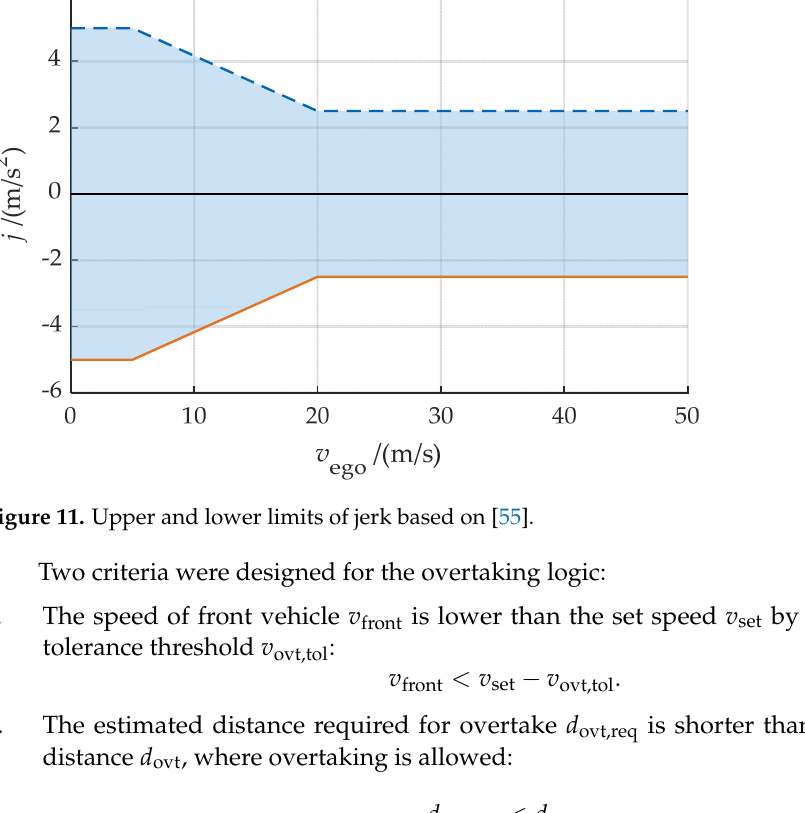
Figure 10. Upper and lower limits of acceleration according to ISO 15622:2018 [55].